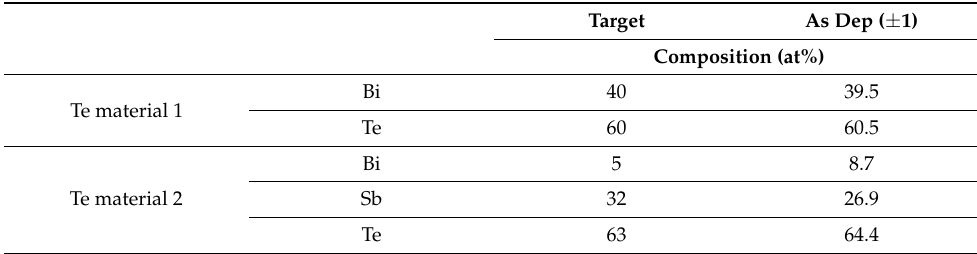
Table 1. Composition of thermoelectric chalcogenide sputtering targets Bi 0.40 Te 0.60 and Bi 0.05 Sb 0.32 Te 0.63 and as-deposited coatings. Composition was obtained by EDX on 500 nm thick active layers to maximise precision of analysis, as electron beam interaction volume is well known to probe several microns in depth, leading to additional error in very thin samples